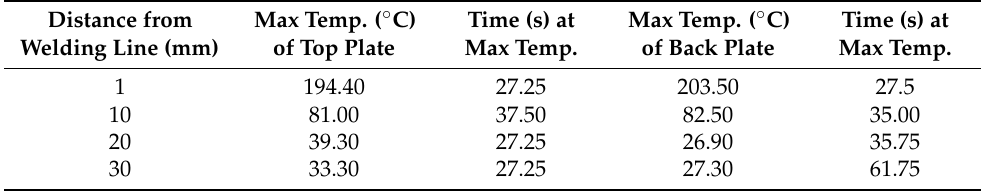
Table 9. Maximum temperature and the time when the maximum temperature.